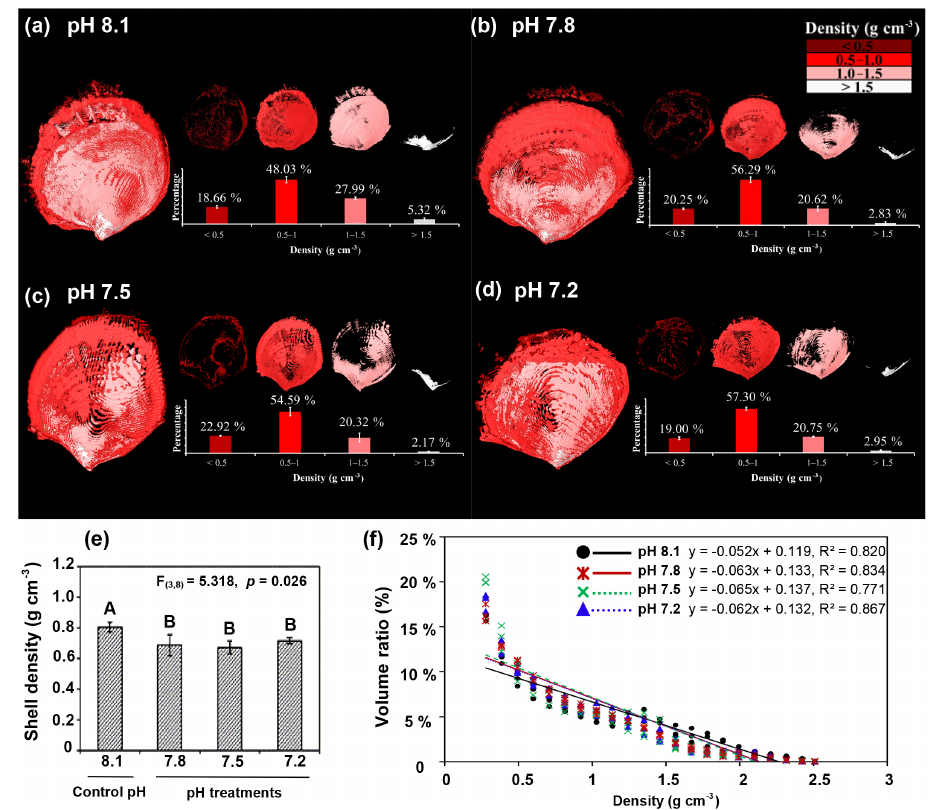
Figure 6. Effects of low pH on the shell density map (a–d) , overall density (e) , and shell density–volume ratio relationships (f) for the four experimental pH treatment groups were examined by micro-CT of shells of Magallana angulata . Three-dimensional reconstructions represent the density distribution of the shells produced in ambient or control pH 8.1 (a) , treatment pH 7.8 (b) , pH 7.5 (c) and pH 7.2 (d) . The volume ratios of density categories of <0.5, 0.5–1.0, 1.0–1.5, and >1.5gcm − 3 were quantified. (e) The overall density was presented as mean ± SD of three replicates ( n = 3). (f) shell density–volume ratio relationships for the four experimental pH treatment groups of C. angulata . Regression lines for the three low pH treatments closely overlap and are partly